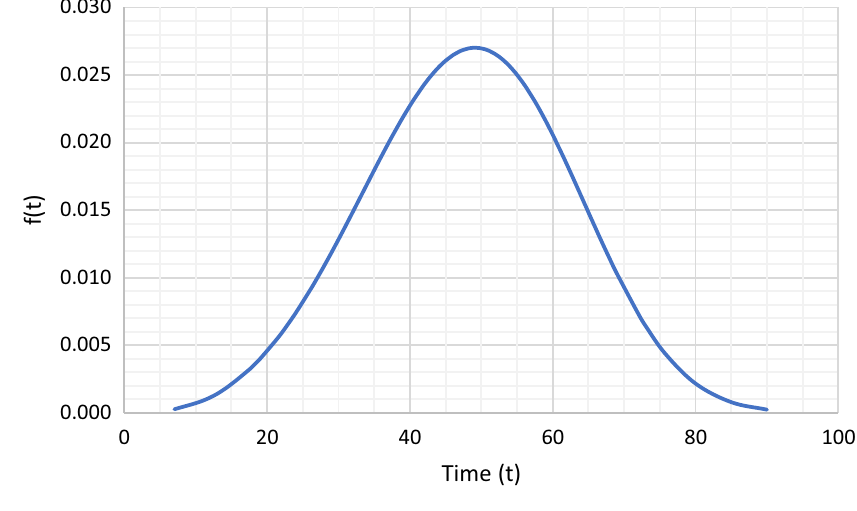
Fig. 4 Weibull distribution showing failure density function (f(t)) of drill bits Table 1 Optimum